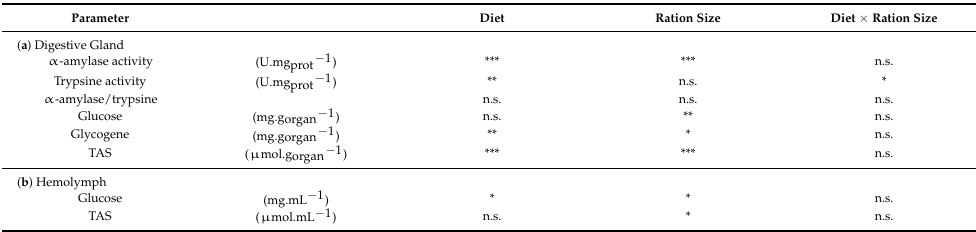
Figure 2. ( a ) α -amylase activity, ( b ) glycogen level and ( c ) glucose level in digestive gland; ( d ) glucose level in haemolymph of L. stylirostris according to ration size and dietary treatment at the trial’s end- point. Data shown as mean ± SD, n = 3 with 4 shrimps/tank assessed. Asterisk indicate significant differences between diets at each ration size (2-way ANOVA, PLSD; * p < 0.05, ** p < 0.01). Table 7. Statistical significance of diet, ration size and their interaction for each biochemical parameter measured in the ( a ) digestive gland and ( b ) haemolymph (2-way ANOVA; n.s., non-significant; * p < 0.05, ** p < 0.01, *** p <